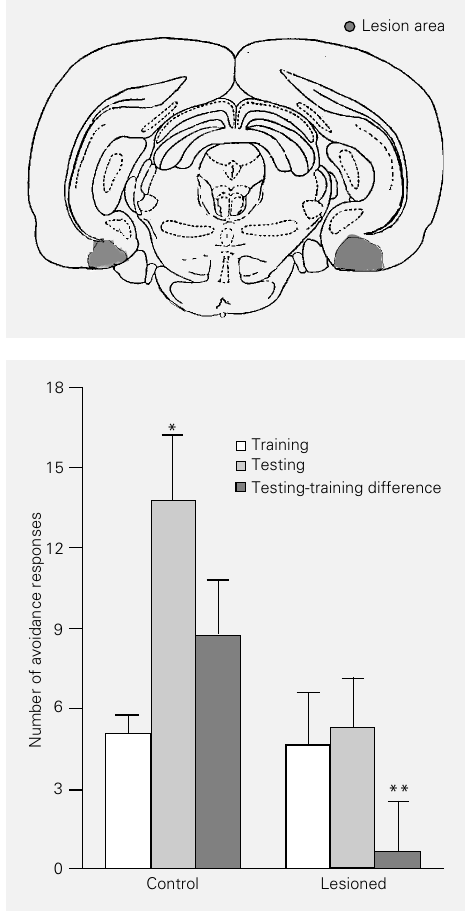
Figure 2 - Effect of a pretraining lesion of the entorhinal cortex on performance in a two-way ac- tive avoidance task. Data are re- ported as means ± SEM (N = 8 animals/group). *P<0.005 com- pared to the training session (paired Student t -test). **P<0.02 compared to the control group (unpaired Student t